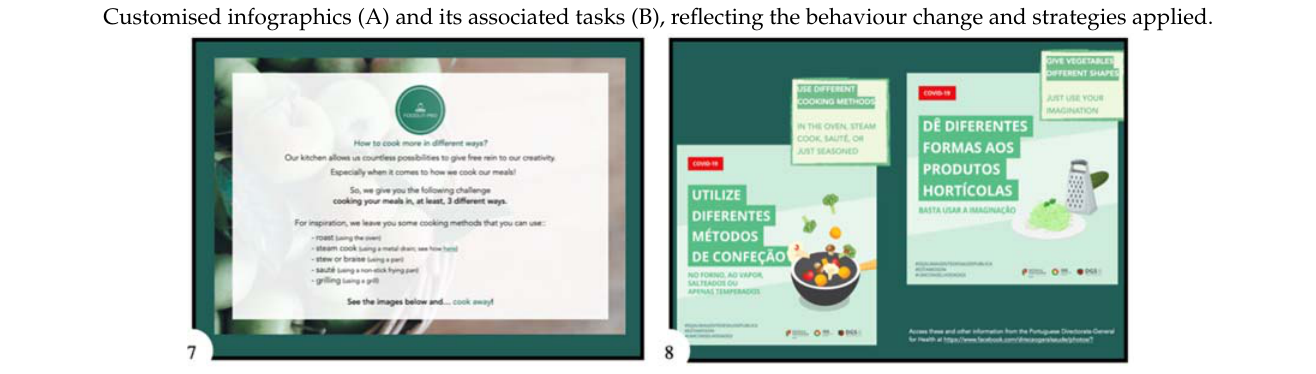
Table 2. Example of the FOODLIT-Trial’s experimental group Week 4 (themed Cooking) and Week 11 (themed Actors), entailing (A) customised infographics; (B) its associated tasks, presented within the infographics and reflecting the behaviour change strategies applied; and (C) corresponding items, to be responded to before the end of the week.